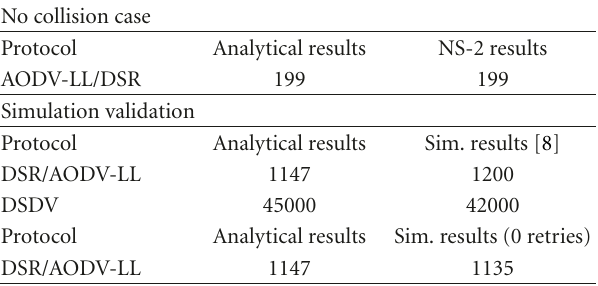
Table 2: Routing overhead: Simulation results reported by Broch et al. [8] versus the analytical results.